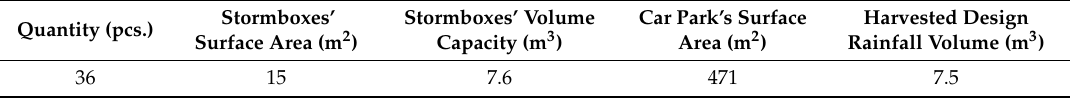
Table 11. Data summary for infiltration boxes